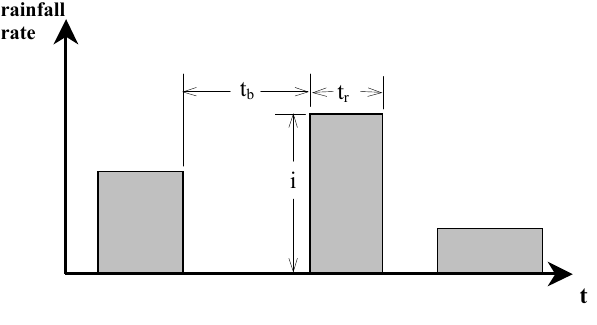
Fig. 1. The rectangular pulse model of